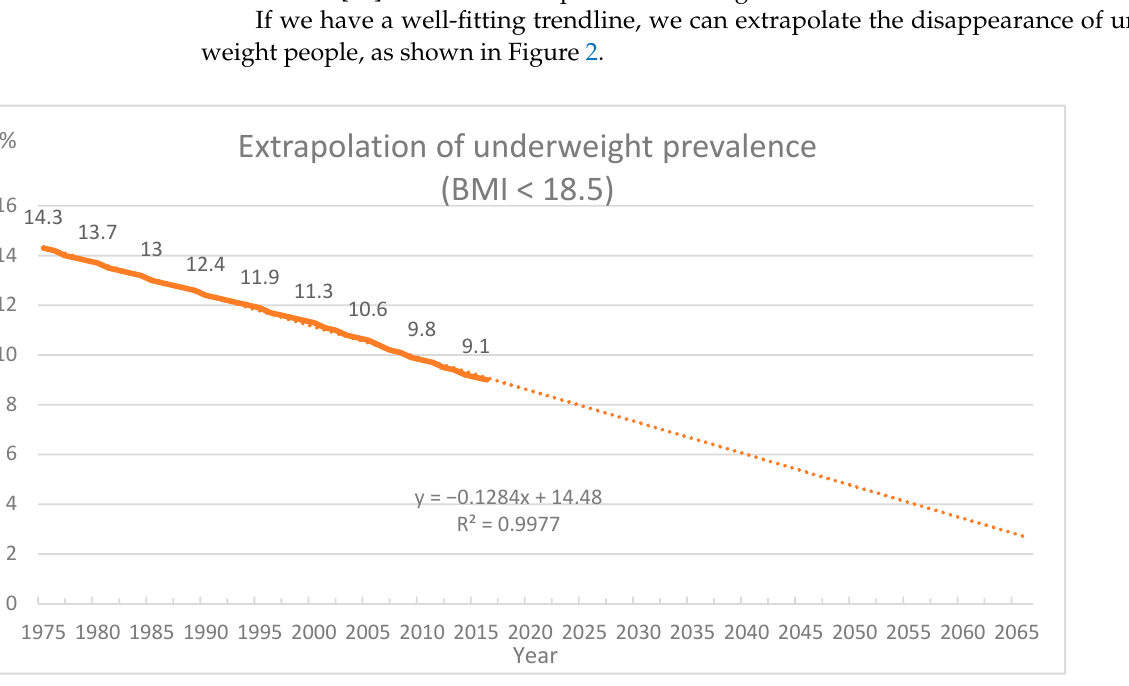
Figure 2. Extrapolation of the proportion of underweight people. Source: own edition based on [28].